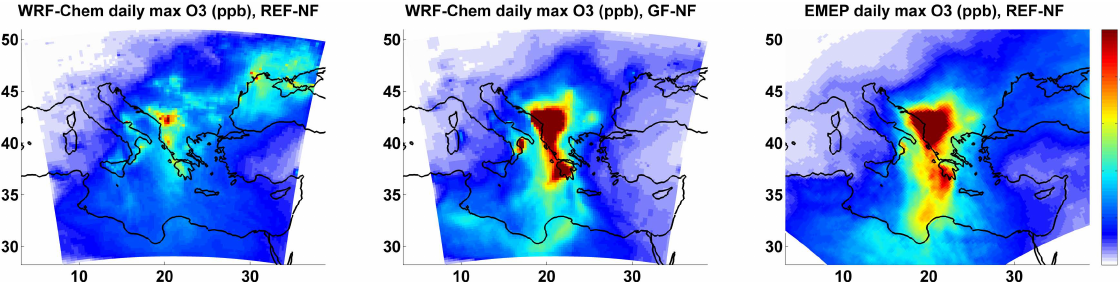
Fig. 11. Change in daily maximum near-surface ozone (ppbv) due to forest fire emissions (REF-NF and GF-NF) calculated by WRF-Chem using FINN emissions (left), WRF-Chem using GFED emissions (middle), and EMEP MSC-W using GFED emissions (right) averaged over the summer (JJA)